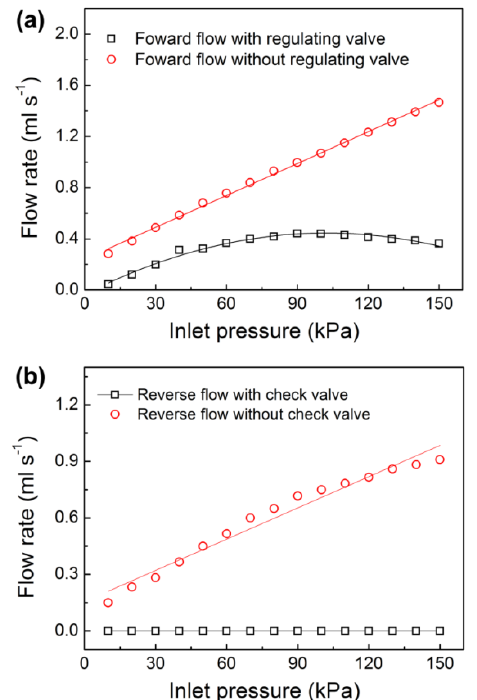
Figure 8. Measured flow rates of the microfluidic flow regulatory device under test pressures from 10 kPa to 150 kPa in ( a ) Forward mode and ( b ) Reverse mode.